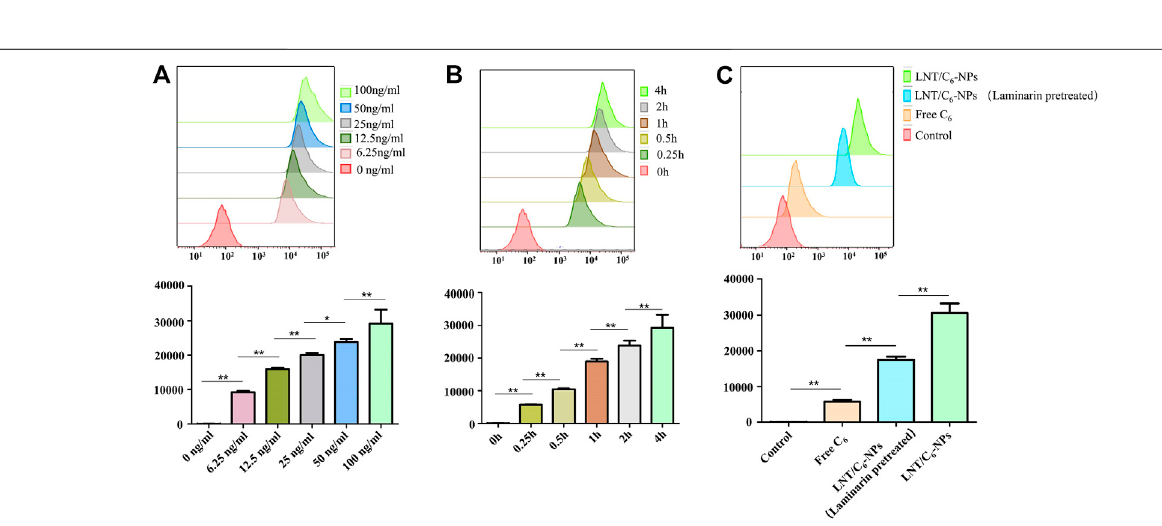
Frontiers in Bioengineering and Biotechnology |